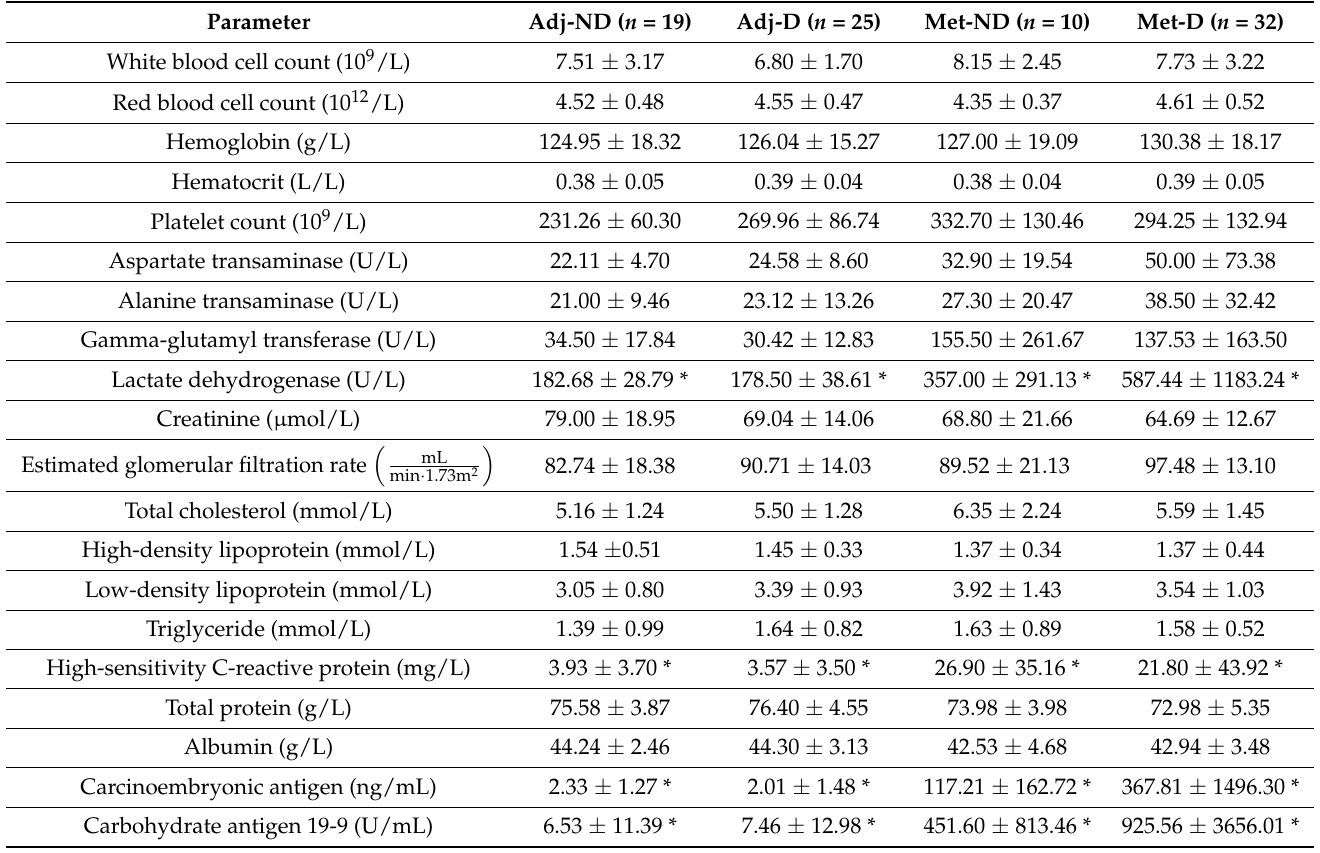
Table 2. Baseline laboratory measurements of study participants. Besides a few parameters affected by the presence of metastases, laboratory parameter measurement data suggested that the study population was homogenous at the time of